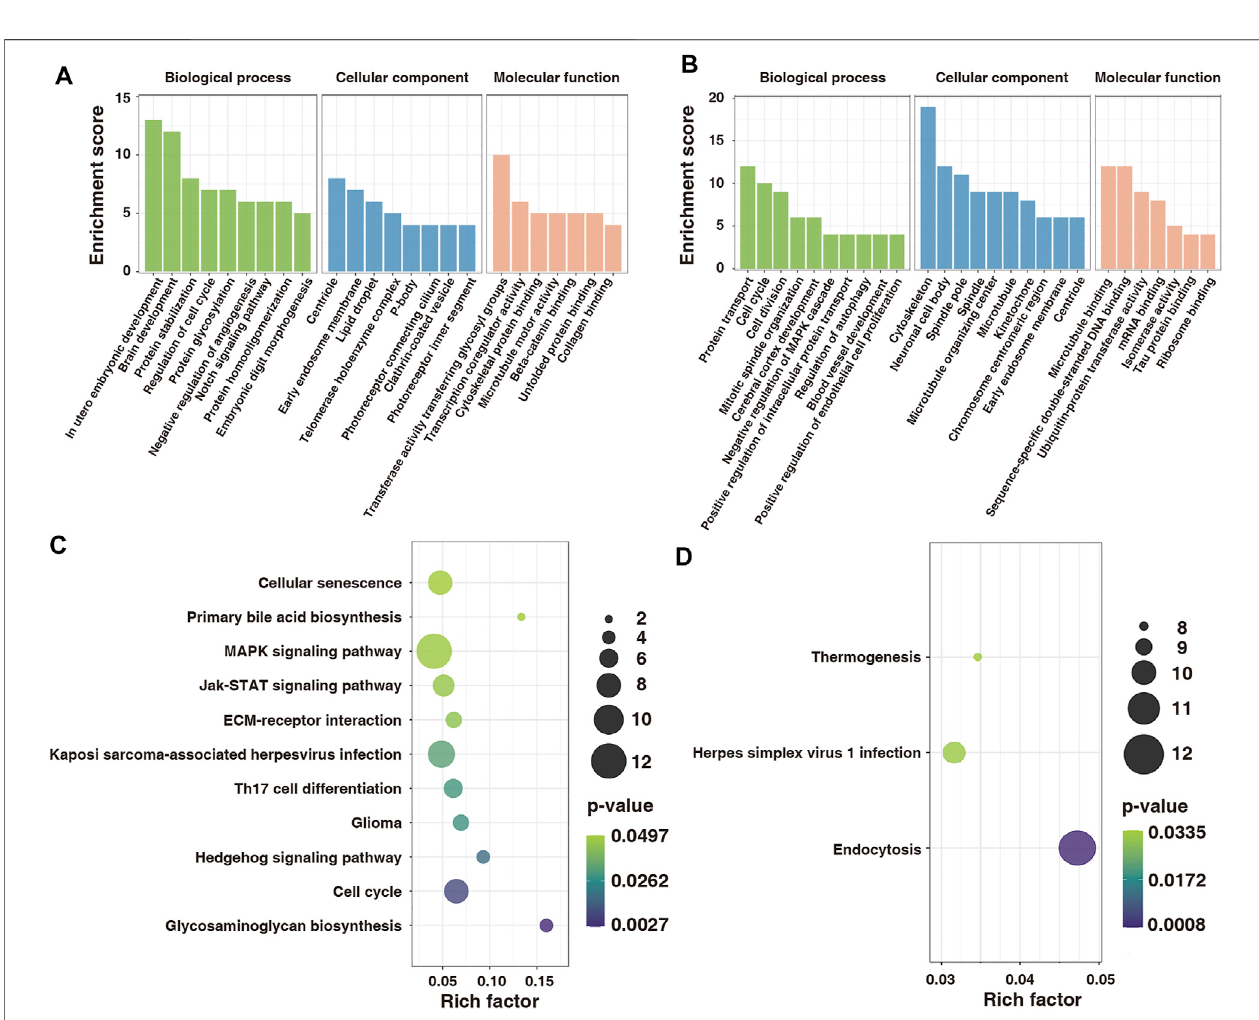
FIGURE 5 | GO and KEGG functional annotation for differentially modi fi ed genes in control and model groups. (A) GO enrichment of hypermethylated genes. (B) GO enrichment of hypomethylated genes. (C) Enrichment of hypermethylated genes in the KEGG pathway. (D) Enrichment of hypomethylated genes in the KEGG pathway. GO, Gene Ontology; KEGG, Kyoto Encyclopedia of Genes and Genomes.